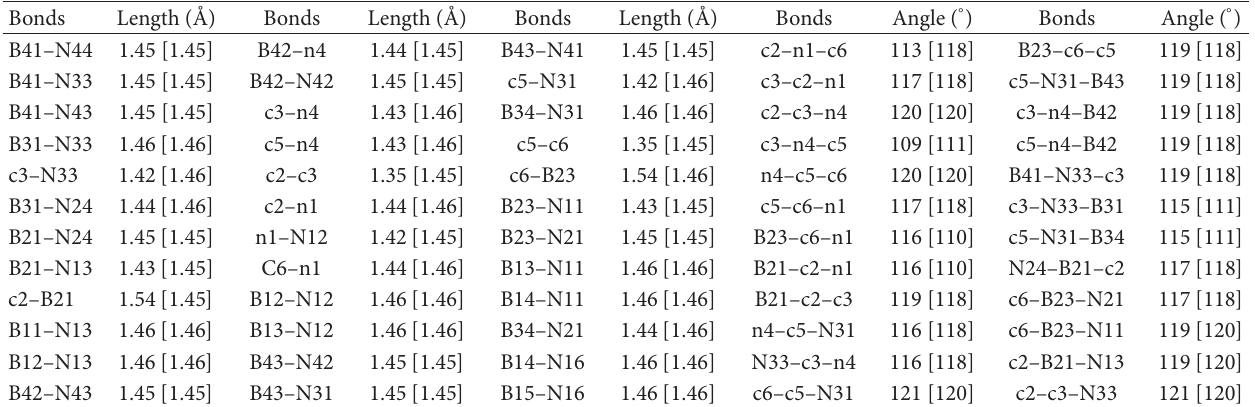
) for the perfect (in bracket) and PD-BNNT models (b) at B3LYP/6-311G ∘